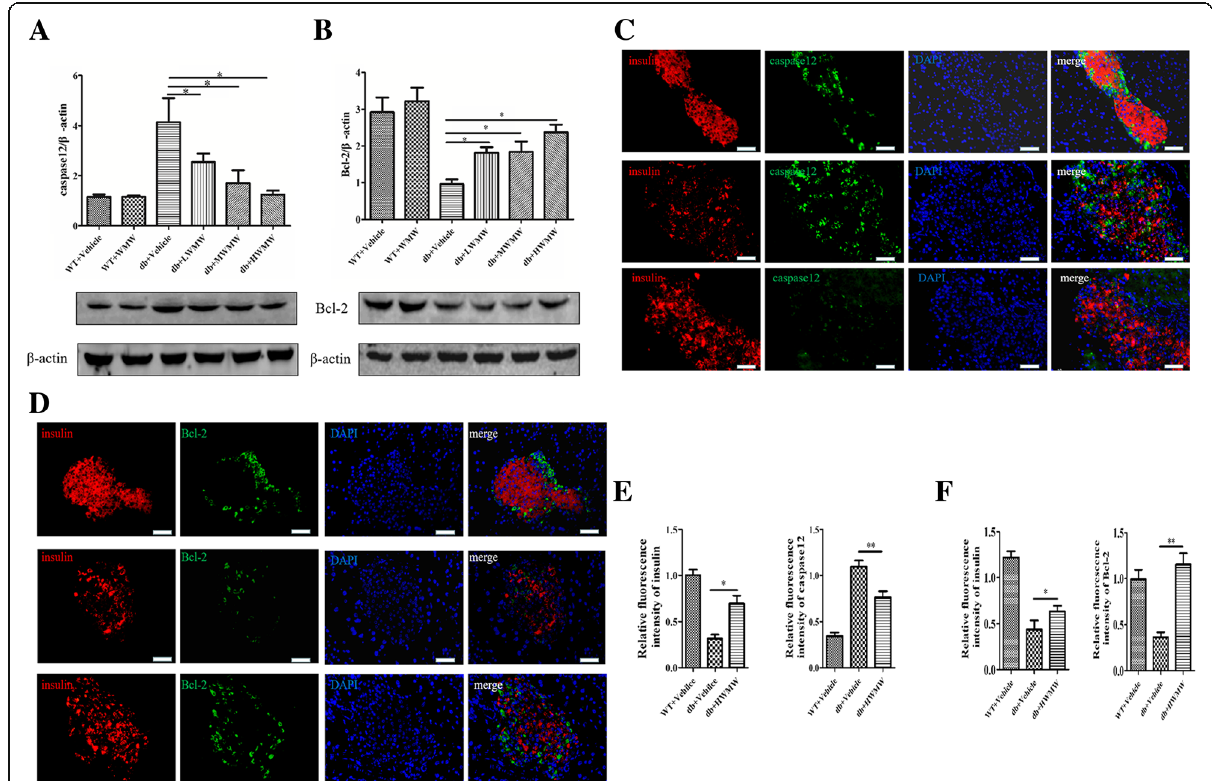
Fig. 4 Effect of WMW on the expression of proteins related to apoptosis in the mouse pancreas. Western blot analyses were ( a ) caspase-12 and ( b ) Bcl-2. Band densities were converted to a bar graph. Immunofluorescence staining for insulin (red) and caspase-12 (green) or Bcl-2 (green) in pancreatic islets from wild-type, db/db, and db/db mice treated with HWMW are illustrated in ( c ) or ( d ). Nuclei were counterstained with DAPI (blue). Signals for caspase-12 and Bcl-2 were calculated in the bar graph ( e , f ). Scale: 25 μ m. P < 0.05 (*), P < 0.01 (**) ( n =